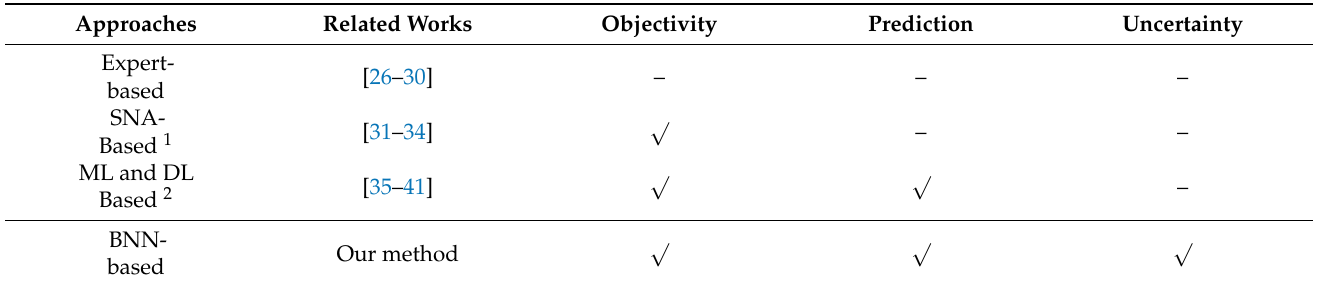
Table 1. Comparison of previous studies on technology